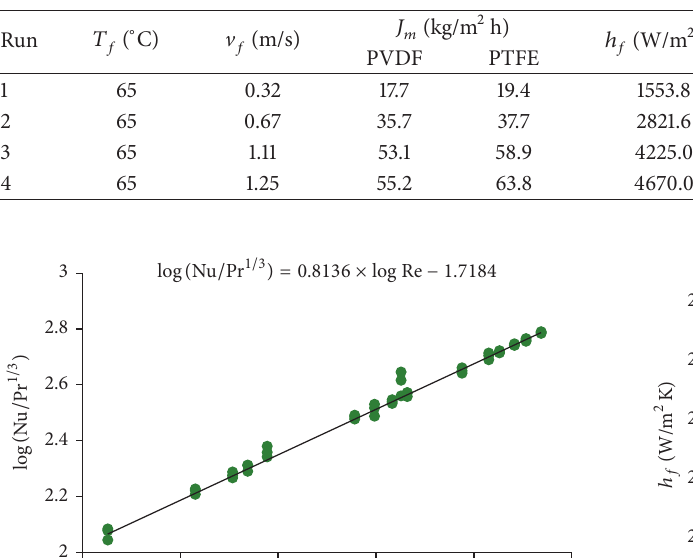
Table 2: Pure water VMD experimental results for PVDF and PTFE at a 92 kPa vacuum degree.